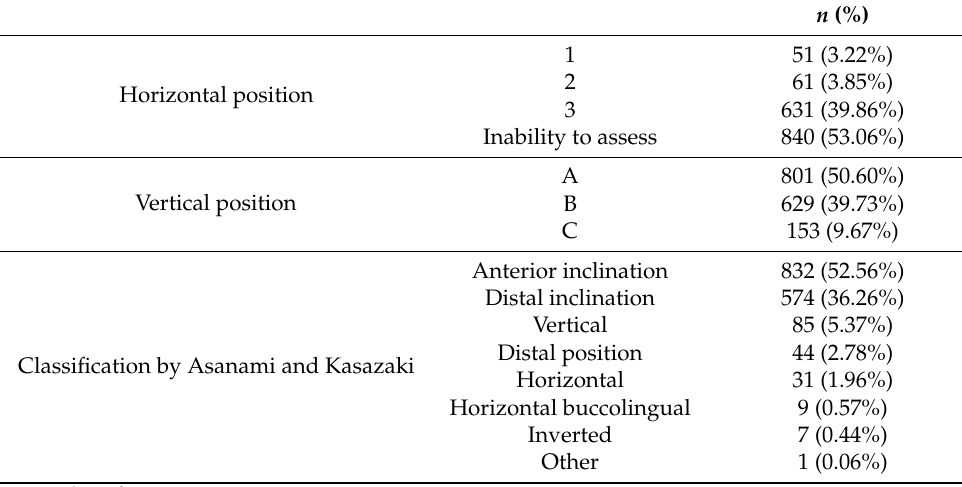
Table 6. Frequency of impaction degrees among impacted mandibular third molars according to Asanami and Kasazaki in the study